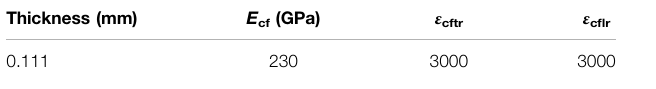
TABLE 4 | Mechanical property of CFRP.